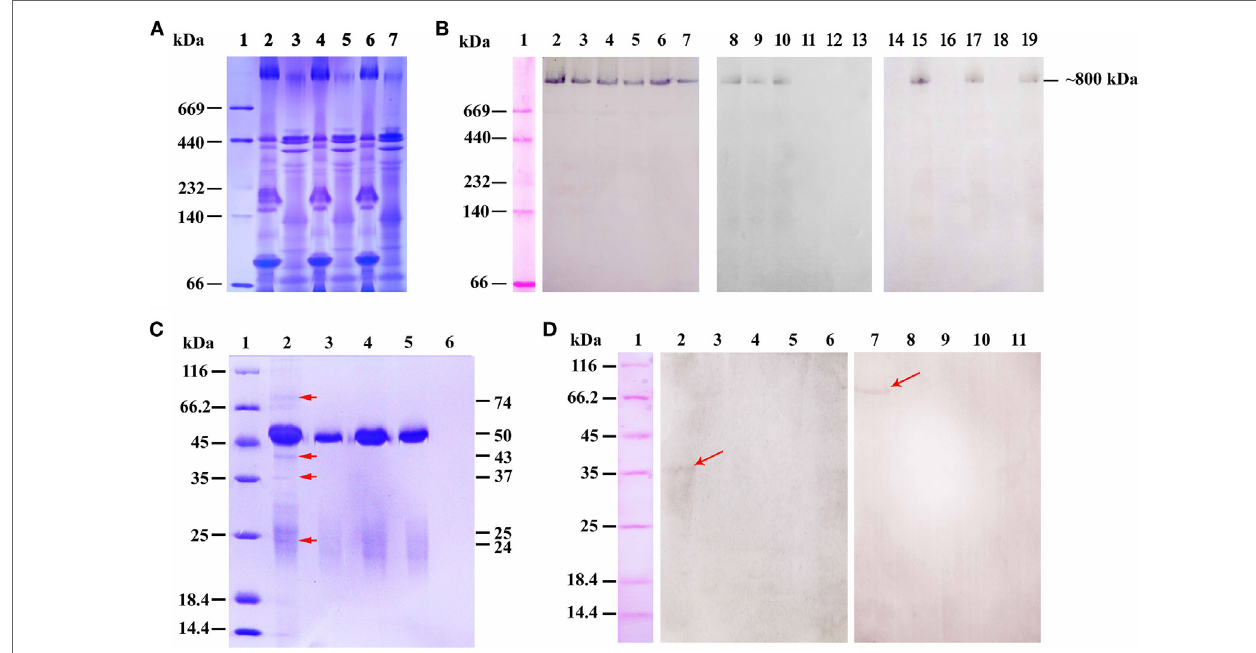
FigUre 7 | The pIgR associated IgM–ovalbumin (OVA) complexes in intestinal mucus of group 1 at 6 h after OVA challenge. (a,B) The Native-PAGE under non-reducing condition that stained by Coomassie blue and analyzed by western blot. (a) Lane 1: maker, lanes 2–7: native-PAGE result of serum and gut mucus of group 1 (2–3), group 2 (4–5), and group 3 (6–7), respectively. (B) Western blot result. Lane 1: maker, lanes 2–7: the samples of (a) reacted with anti-IgM monoclonal antibody (MAb) 2D8; lanes 8–13: the samples of (a) reacted with rabbit anti-OVA antibody; lanes 14–19: the samples of (a) reacted with mouse anti-pIgR antibody. (c) SDS-PAGE under reducing condition analyzed the samples from co-immunoprecipitation of gut mucus with rabbit anti-OVA antibody after challenge. Lane 1: maker; lane 2: protein G + rabbit anti-OVA antibody + gut mucus of group 1; lane 3: protein G + rabbit anti-OVA antibody + gut mucus of group 2; lane 4: protein G + rabbit anti-OVA antibody + gut mucus of group 3; lane 5: protein G + non-immune rabbit serum + gut mucus of group 1; lane 6: protein G + gut mucus of group 1. (D) Co-immunoprecipitation of gut mucus with anti-OVA antibody, followed by western blotting assay under reducing conditions. Lane 1: maker; lanes 2–6: Samples of (c) reacted with mouse anti-pIgR antibody; lanes 7–11: Samples of (c) reacted with anti-IgM MAb